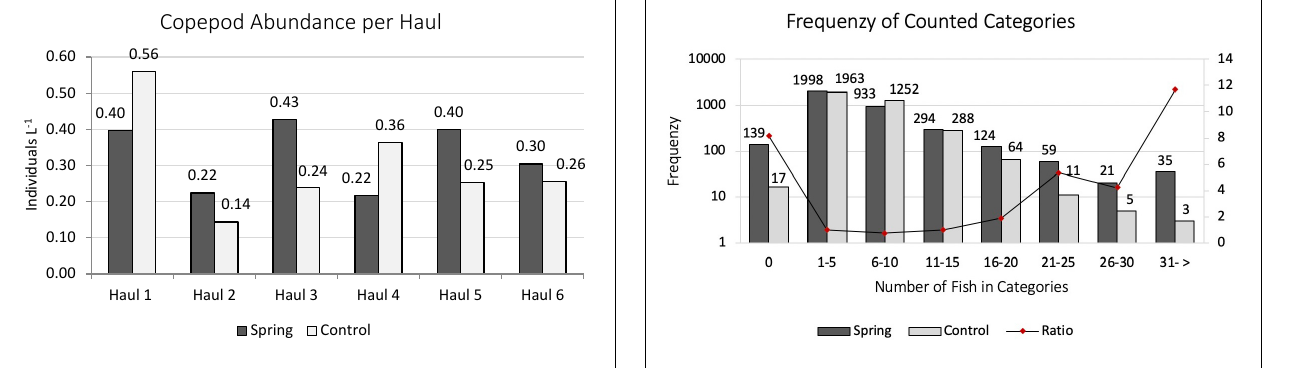
FIGURE 11 | Copepod abundances sampled at the submarine spring site within a diameter of six meters around the submarine spring and the seawater control site.